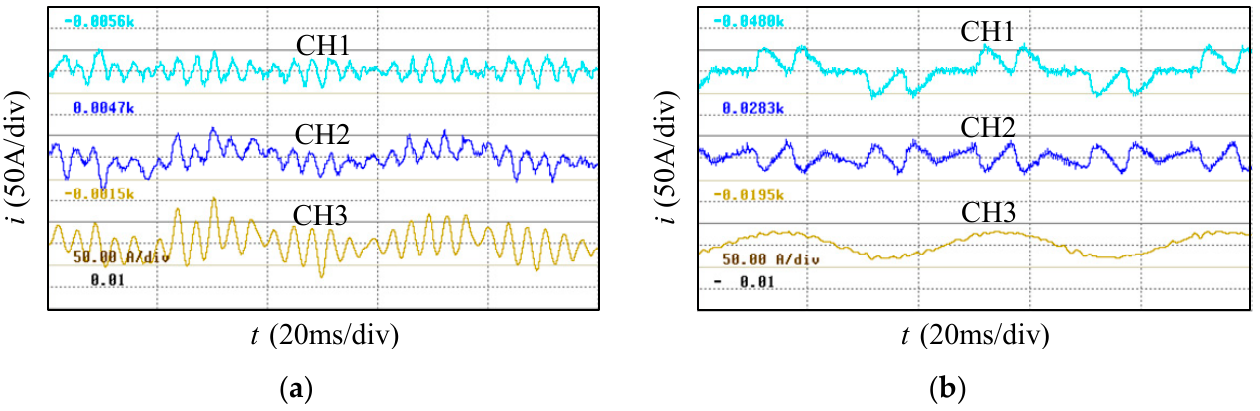
Figure 19. Effects on compound control (CH1—load current containing capacitor; CH2—SAPF current; CH3—grid current) ( a ) when K p = 0; ( b ) when K p = 1.5.